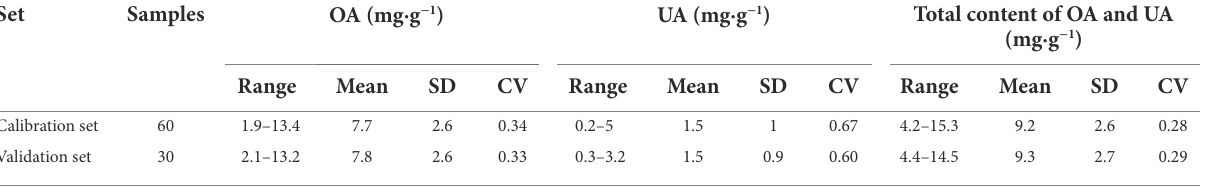
TABLE 1 Statistic results of the calibration set and validation set. Set Samples